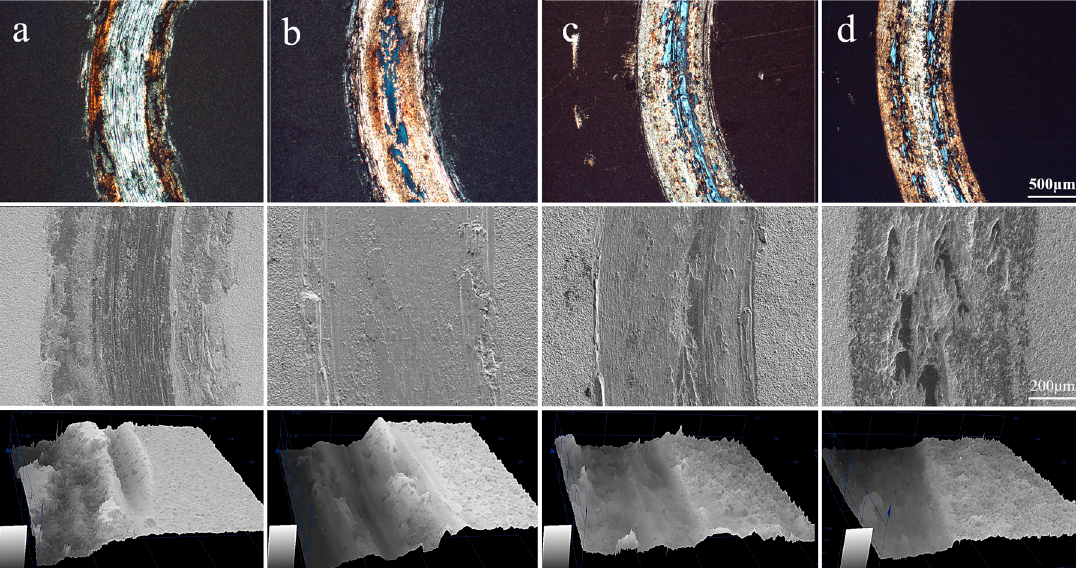
Figure7. The surfacewear morphology of theNi / Cu / Ni coatingsafter annealing at varioustemperatures: Figure 7. The surface wear morphology of the Ni/Cu/Ni coatings after annealing at various ( a ) untreated, ( b ) 600 ◦ C, ( c ) 700 ◦ C, and ( d ) 800 ◦ C, temperatures: ( a ) untreated, ( b ) 600 °C, ( c ) 700 °C, and ( d ) 800 °C, respectively.